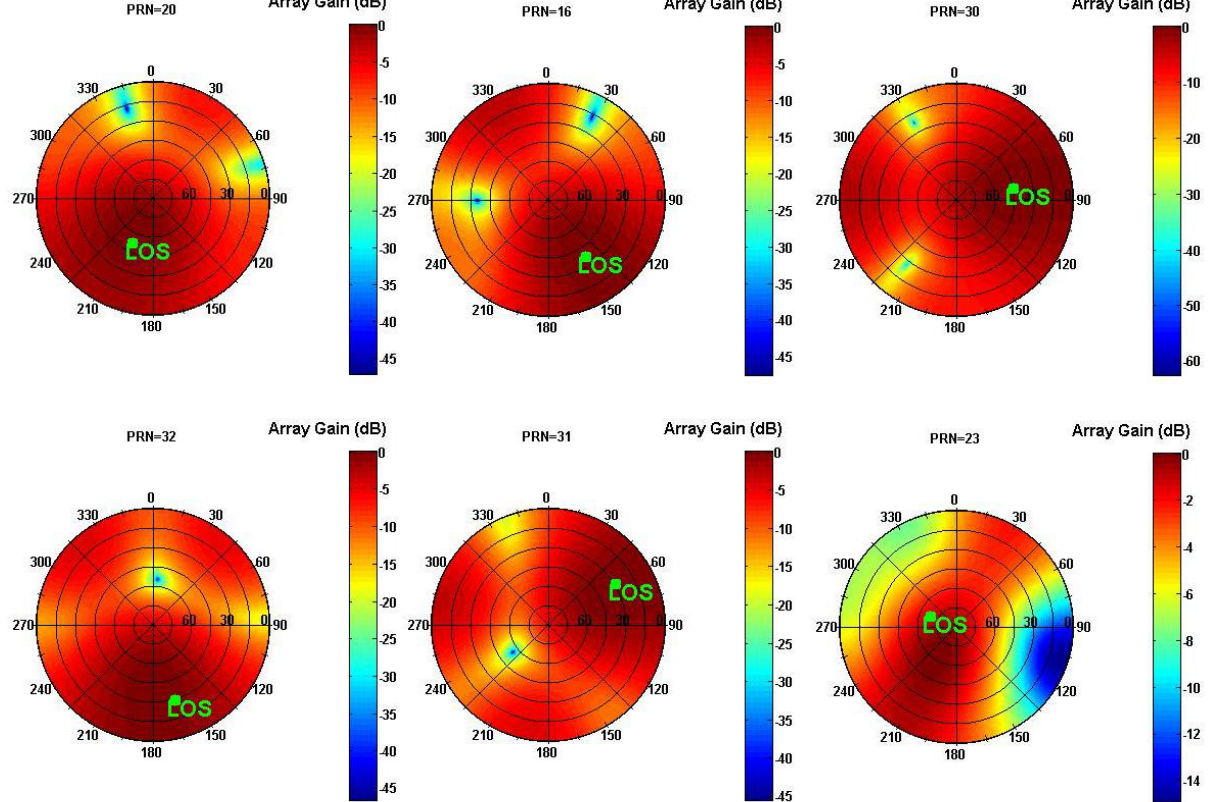
Figure 14. Normalized array antenna beam patterns after beamforming for PRNs 20, 16, 30, 32, 31 and 23.